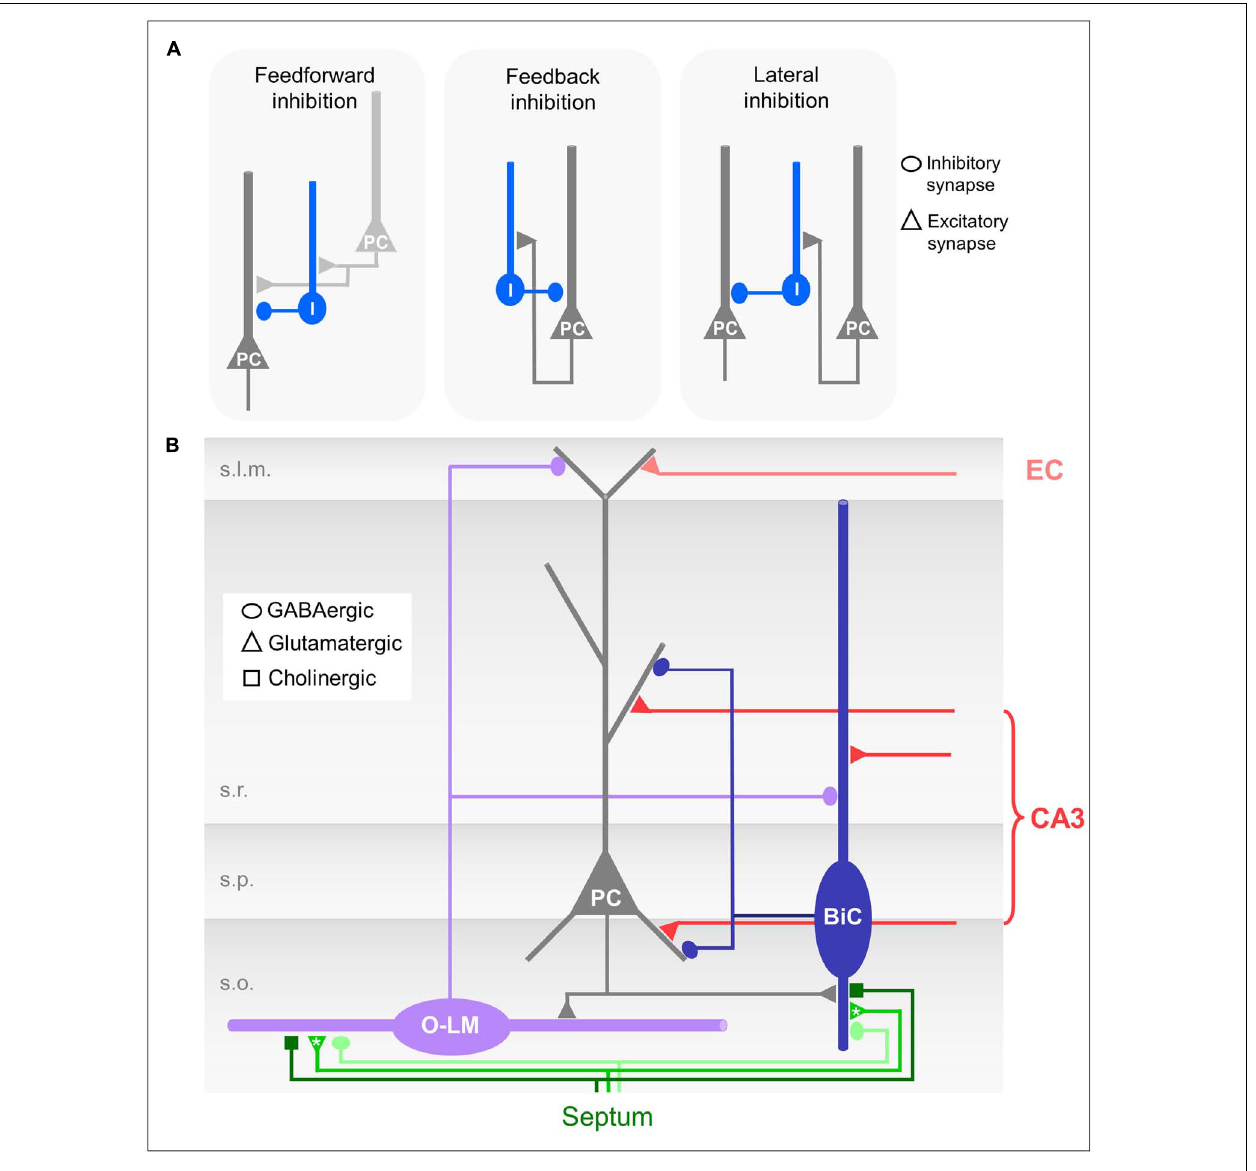
FIGURE 2 | (A) Schematic drawings of different forms of microcircuit organizations. Dark gray neuron: CA1 pyramidal cell (PC); light gray: CA3 pyramidal cell; blue: CA1 interneuron. (B) Schematic drawing of the CA1